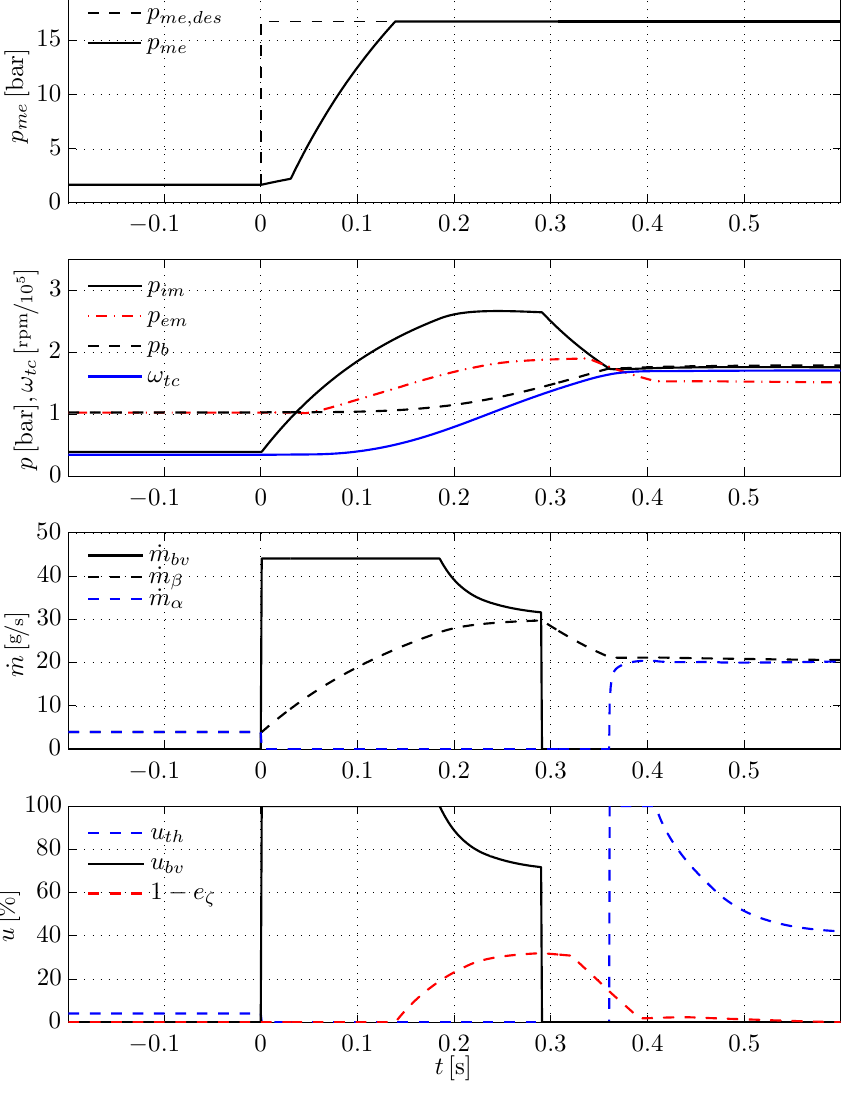
Figure 3. Simulation of a turbo lag compensation with intake manifold boosting for a load step from 1.7 bar to 16.7 bar p